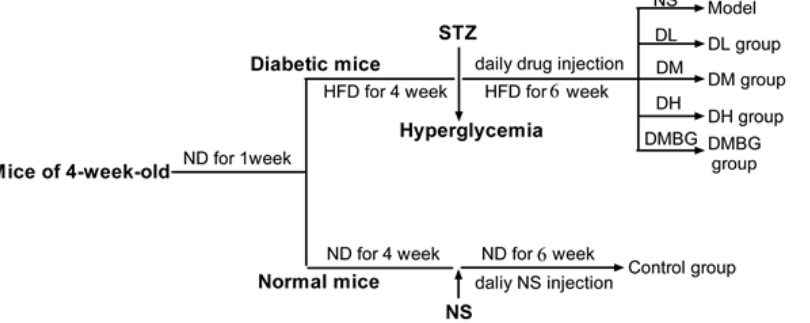
Figure 2. Schematic flow-chart of T2DM model mice establishment and experimental drug admin- istration. T2DM mice were established by feeding HFD daily for 10 weeks and injecting STZ intra- peritoneally at the fourth week. Starting from week 5, mice were administered DL, DM, DH, DMBG for 6 weeks. Each group contained 10 mice. (ND: control feed; HFD: high fat feed; STZ: streptozocin; NS: normal saline; DL: YA 5 mg/kg; DM: YA 10 mg/kg; DH: YA 20 mg/kg; DMBG: metformin).